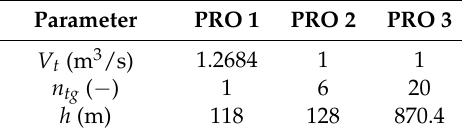
Table 5. Turbine-generator set